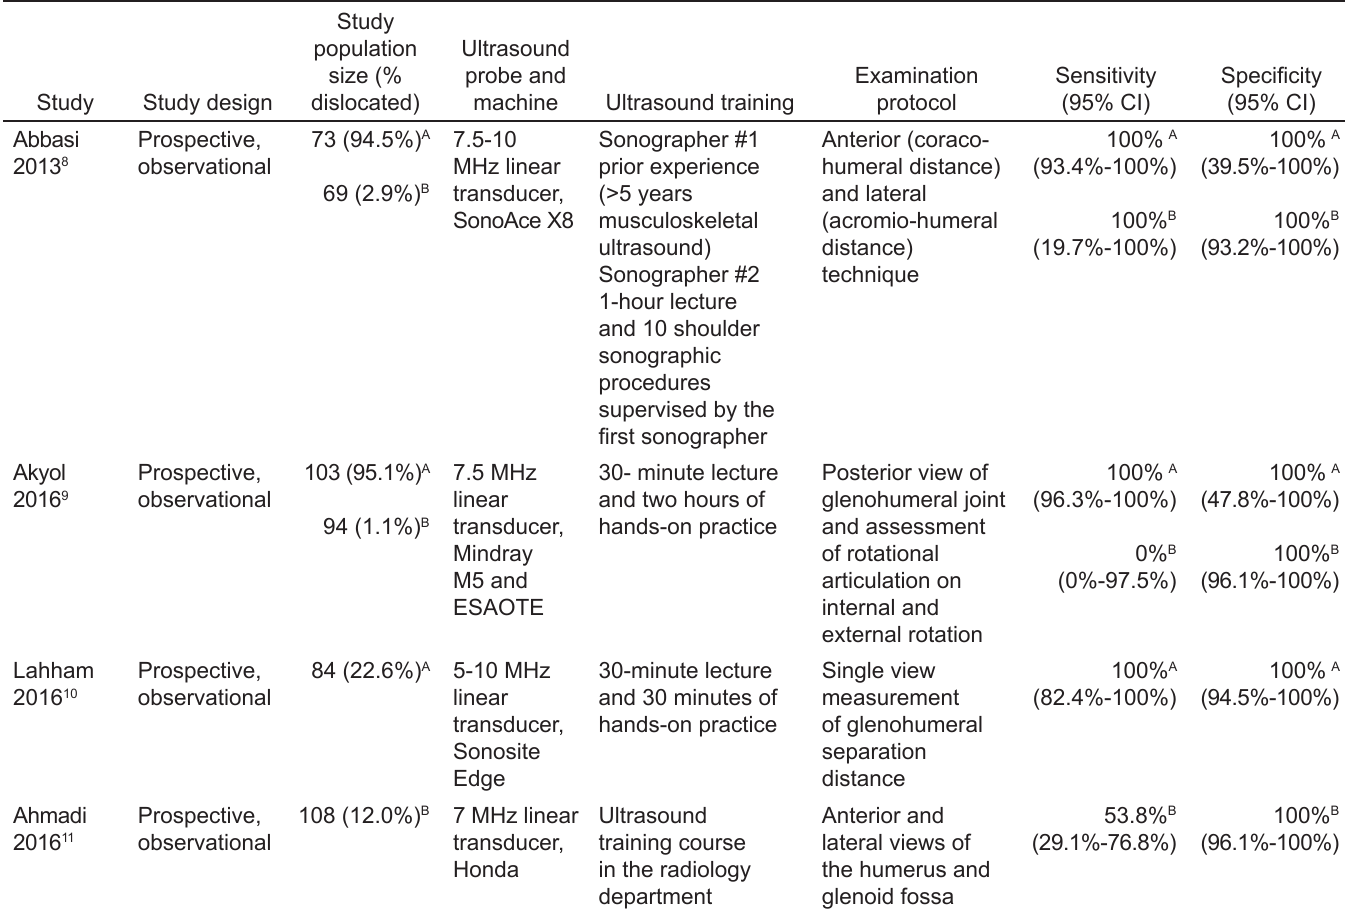
Table 1. Summary of existing studies on the accuracy of ultrasound for shoulder dislocation and reduction.